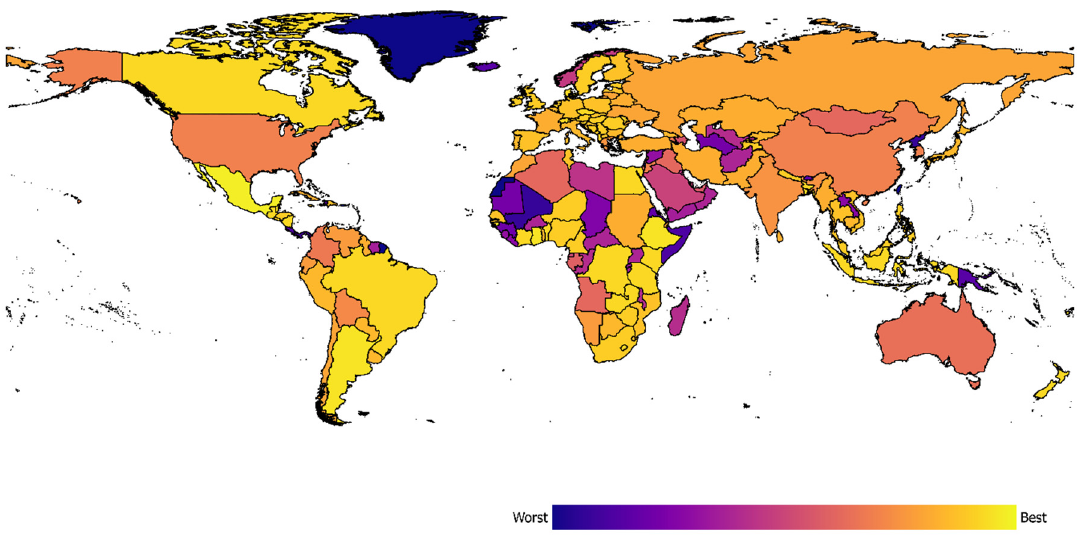
Figure 16. Global view on the military dimension.